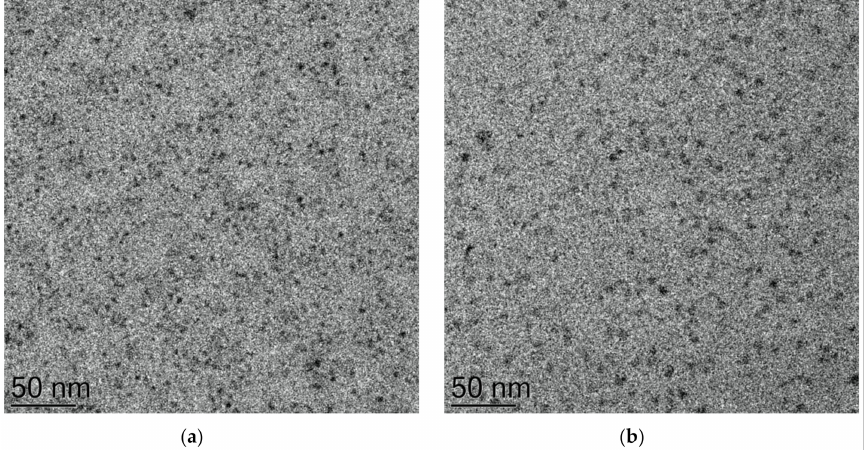
Figure 2. Cryo-TEM micrograph of ( a ) primary emulsion concentrate and ( b ) final nanoemulsion of coconut oil (SOR